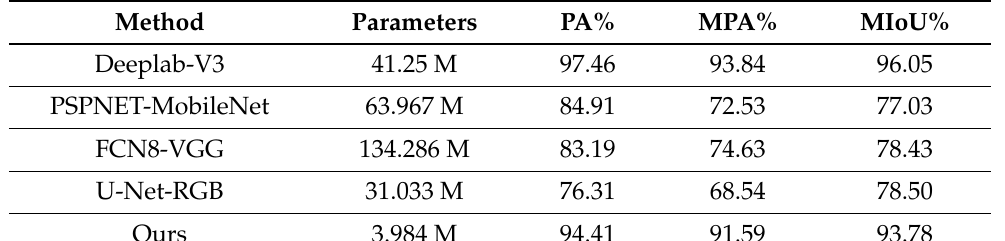
Table 2. Comparison of the proposed scheme with the baseline methods in terms of parameters, pixel accuracy PA, MPA, and IoU.